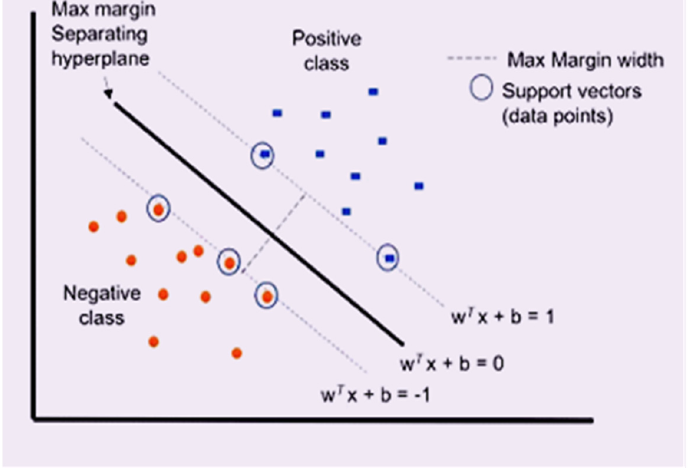
Figure 4. Support Vector Machine Classifier .